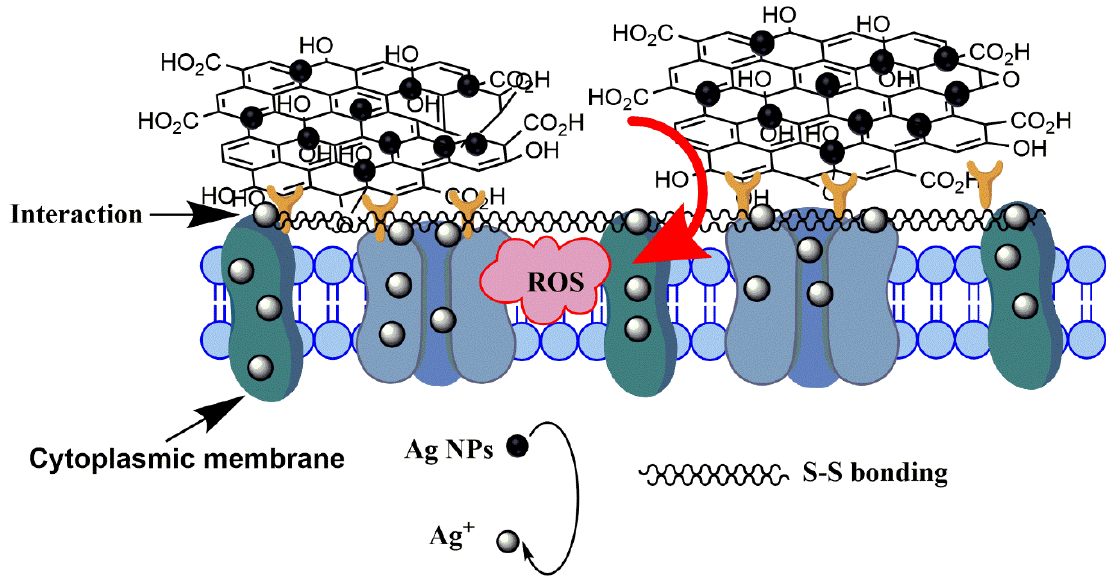
Figure 14. Proposed mechanism of interaction between E. coli and large GO–Ag NPs.